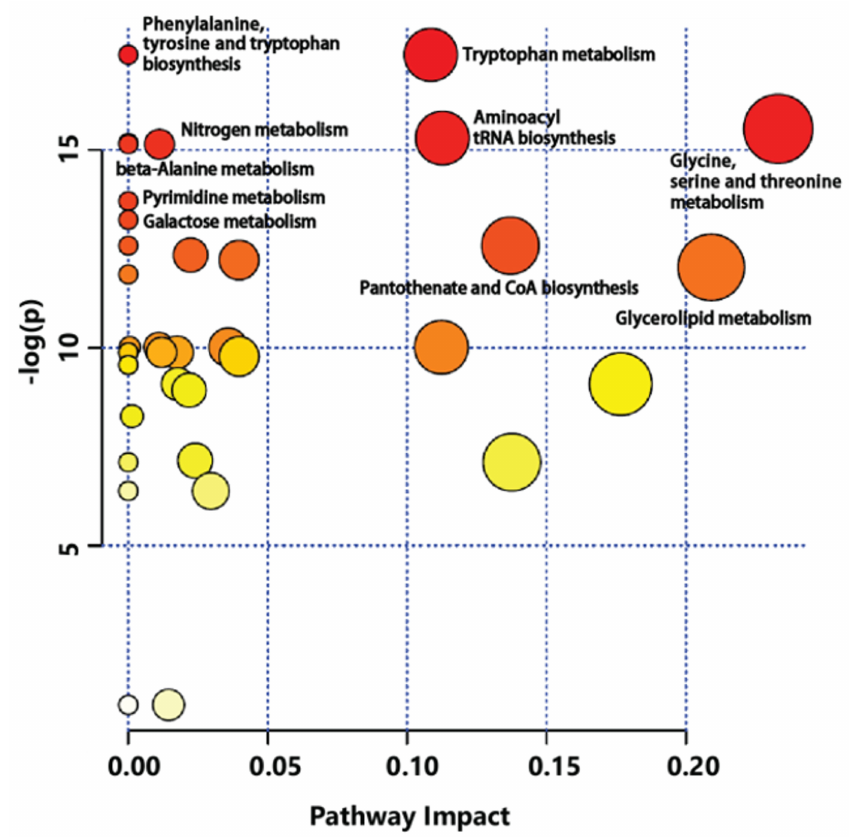
Figure 5. Metabolic pathway analysis (MetPA) displaying metabolic pathways arranged by scores from pathway enrichment (y axis) and from topology analysis (x axis) using MetaboAnalyst to identify the most relevant pathways between three-year-old GB and four-year-old GB. All matched pathways are displayed as circles. Color and size of circles indicate significant changes in metabolites based on p value and pathway impact score in metabolic pathways,